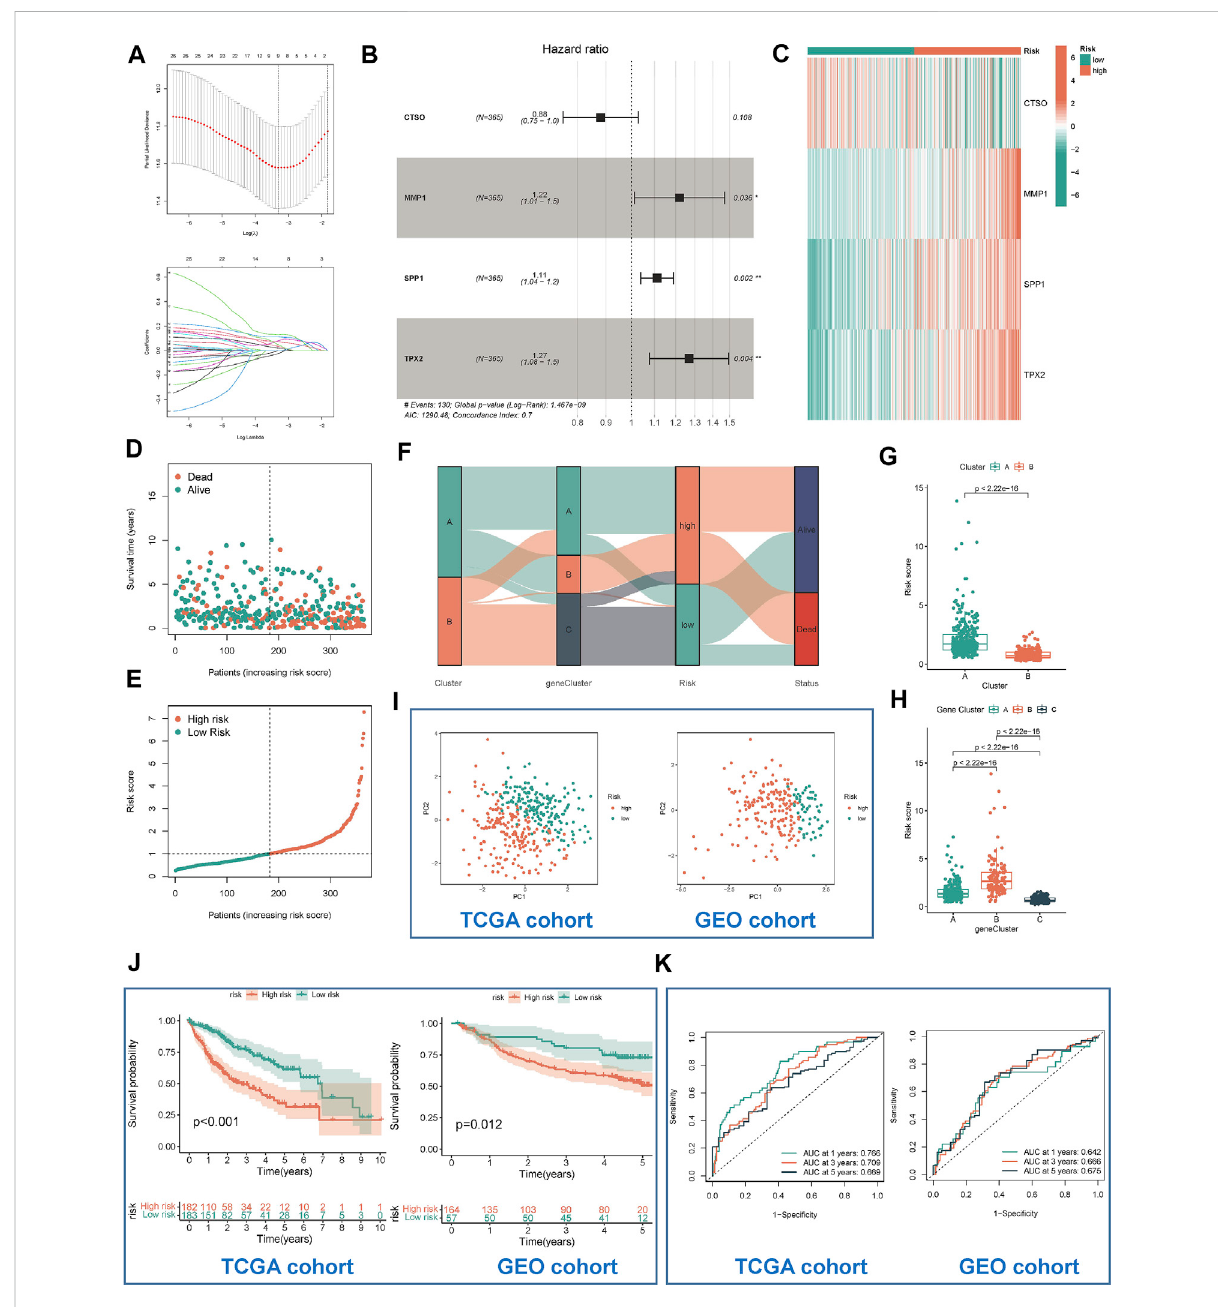
FIGURE 5 Identi fi cation and validation of risk model. (A) Determination of the number of regulators using LASSO analysis. (B) Forest plot of multivariate Cox regression analysis. (C) The heat map showed four HRGTs expression in different risk group (TCGA cohort). Risk status plot (D) and the survival distribution plot (E) demonstrated the poorer prognosis of HCC patients with higher risk score. (F) Sankey diagram based on different subtypes. (G) Differences in risk scores between the two molecular subtypes based on HRGTs. (H) Differences in risk scores between the three molecular subtypesbasedonDEGs.PCAplot (I) ,Kaplan-Meieranalysis (J) ,ROCcurveof1,3,5years (K) ofdifferentriskgroupsintheTCGAandGEOcohort.* p < 0.05, ** p < 0.01, *** p <